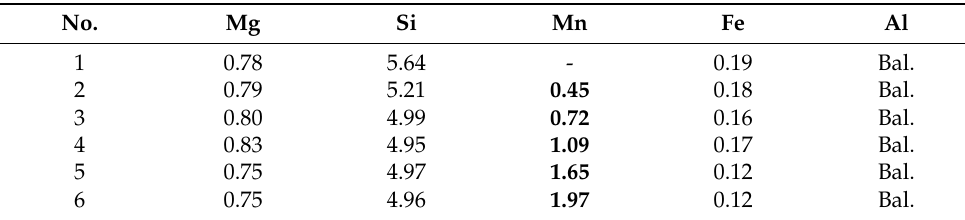
Table 1. Compositions of the alloy ingots in the present study (mass %). No.